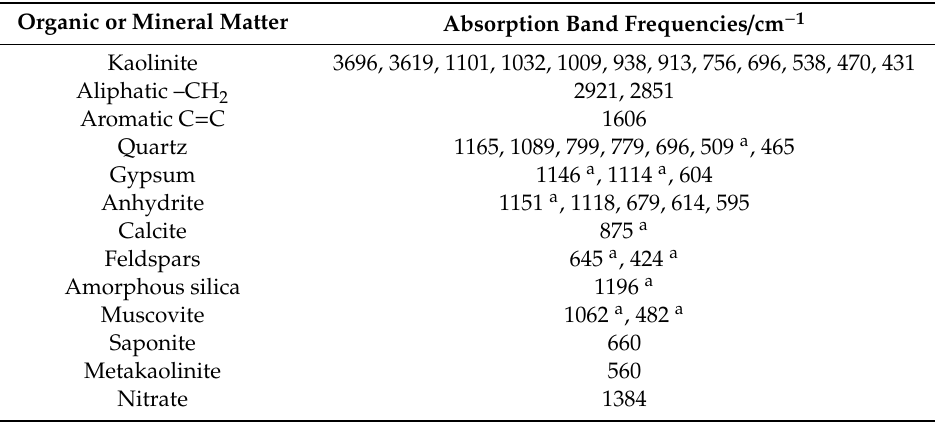
Table 3. FTIR bands of organic and mineral matter in coals and coal